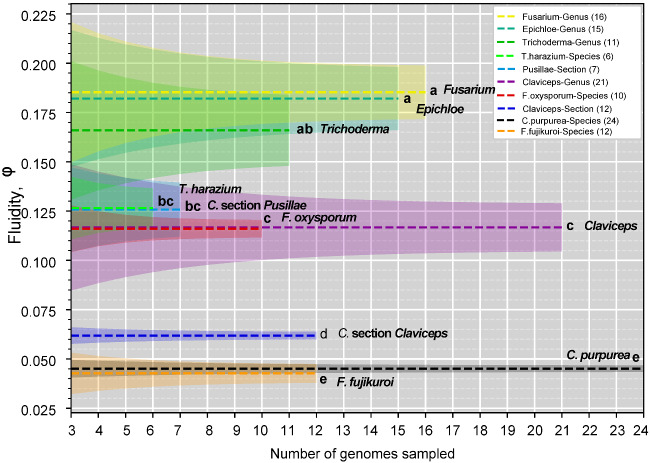
Genomic fluidity (dashed lines) for specified groups within the order Hypocreales. Species level groups contain multiple isolates of a given species, whereas section and genus level groups contain one strain from representative species to remove phylogenetic bias. Shaded regions represent standard error and were determined from total variance, containing both the variance due to the limited number of samples genomes and the variance due to subsampling within the sample of genomes. Letters correspond to significant difference between fluidities determined through a two-sided two-sample z test (P < 0.05; supplementary table S4, Supplementary Material online). Legend is in descending order based on fluidity, and names are additionally appended to mean lines for clarity.